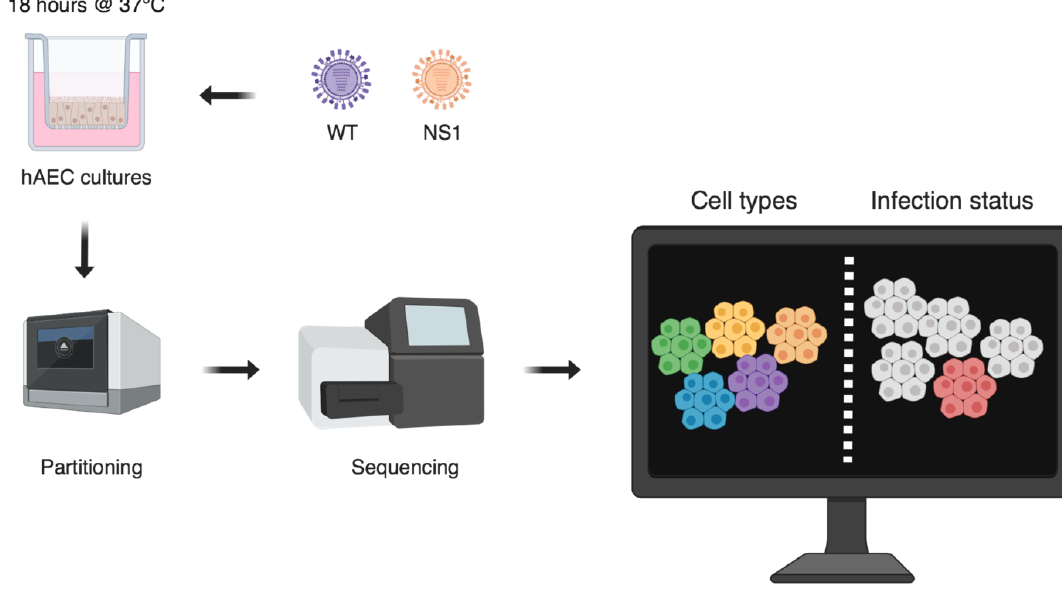
Figure 2. Sequencing and annotation workflow for single influenza-infected cells in the human respiratory epithelium. hAEC, human Airway Epithelial